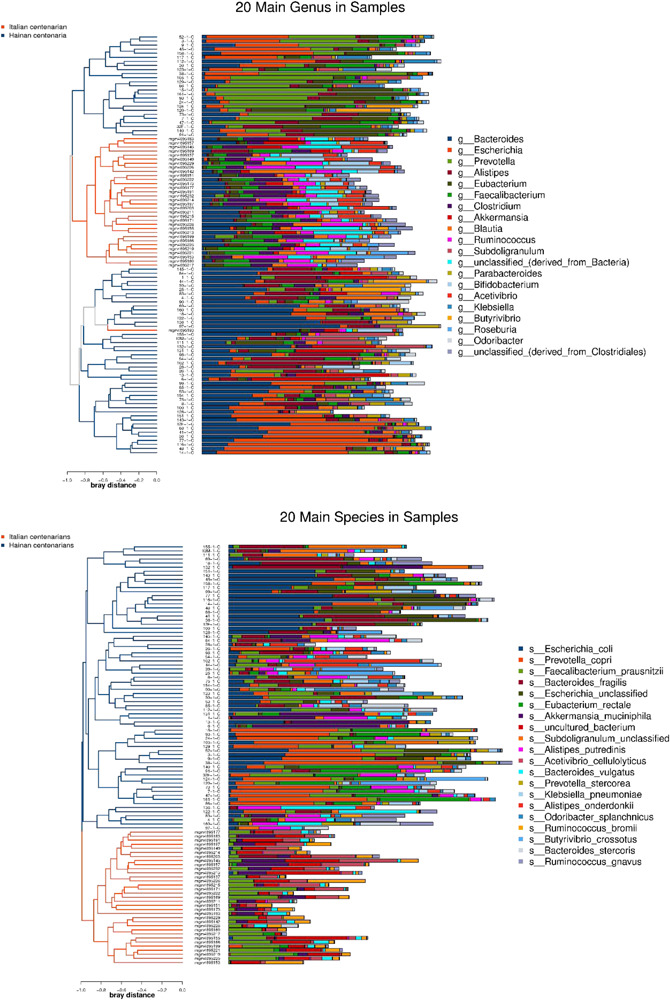
The left side of the figure shows clustering result of the samples, and the color distinguishes the groups of the samples; the middle part illustrates the relative abundance ratio of genera/species level species contained in each sample; the right side shows the genera/species level species represented by each color.